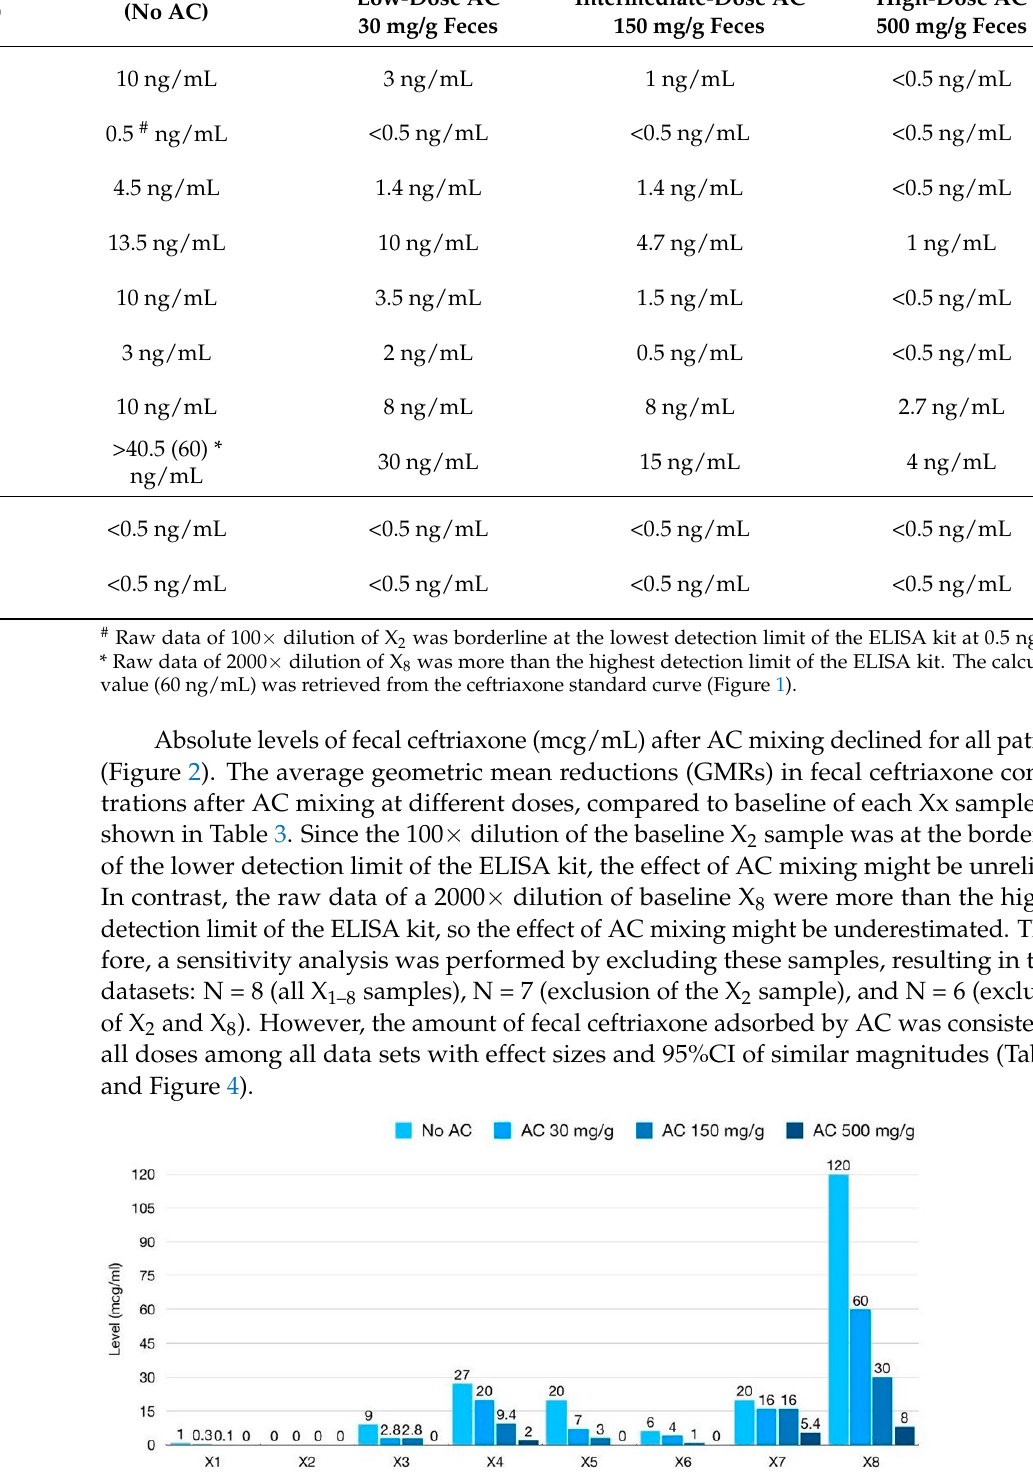
Figure 2. Bar chart comparison of absolute fecal ceftriaxone levels (mcg/mL) at baseline and after mixing with conventional activated charcoal (AC) at different doses: low dose (30 mg/g feces), intermediate dose (150 mg/g feces), and high dose (500 mg/g feces) .